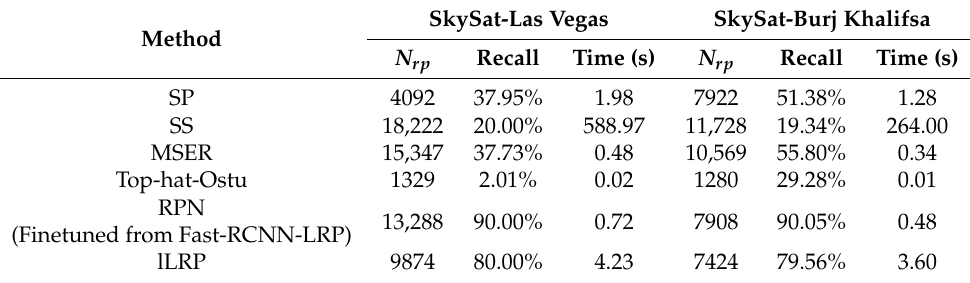
Table 3. Evaluation on region proposal